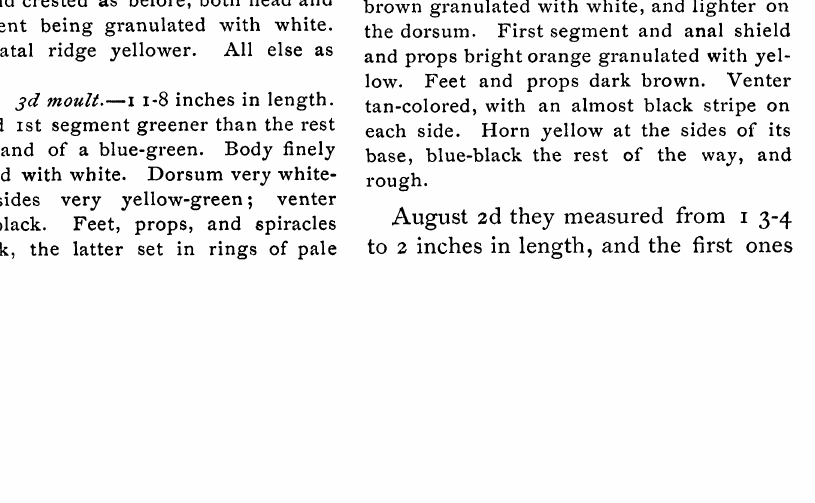
Body deep chocolate brown granulated with white, and lighter on the dorsum. First segment and anal